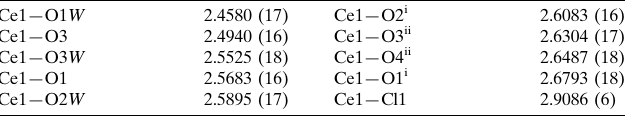
Selected bond lengths (A˚ ).